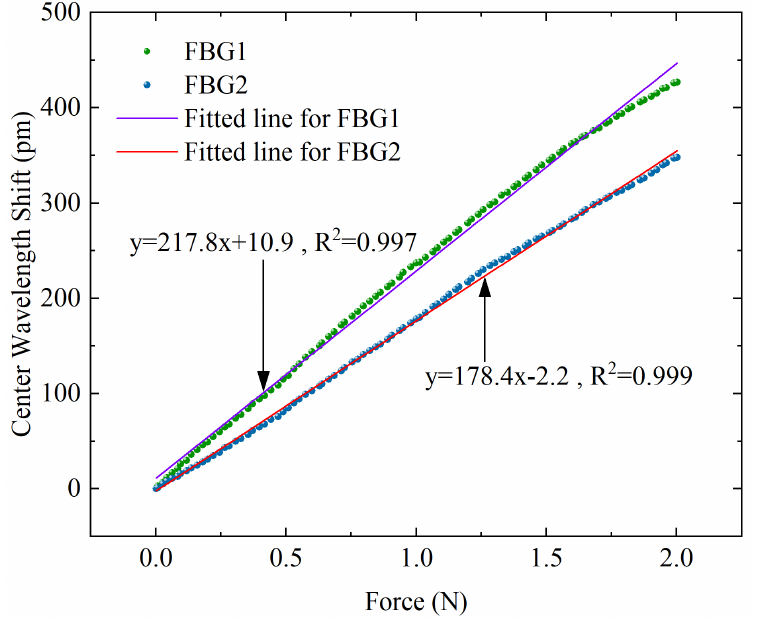
Figure 9. Corresponding response curves of center wavelength shift with different axial forces for the two